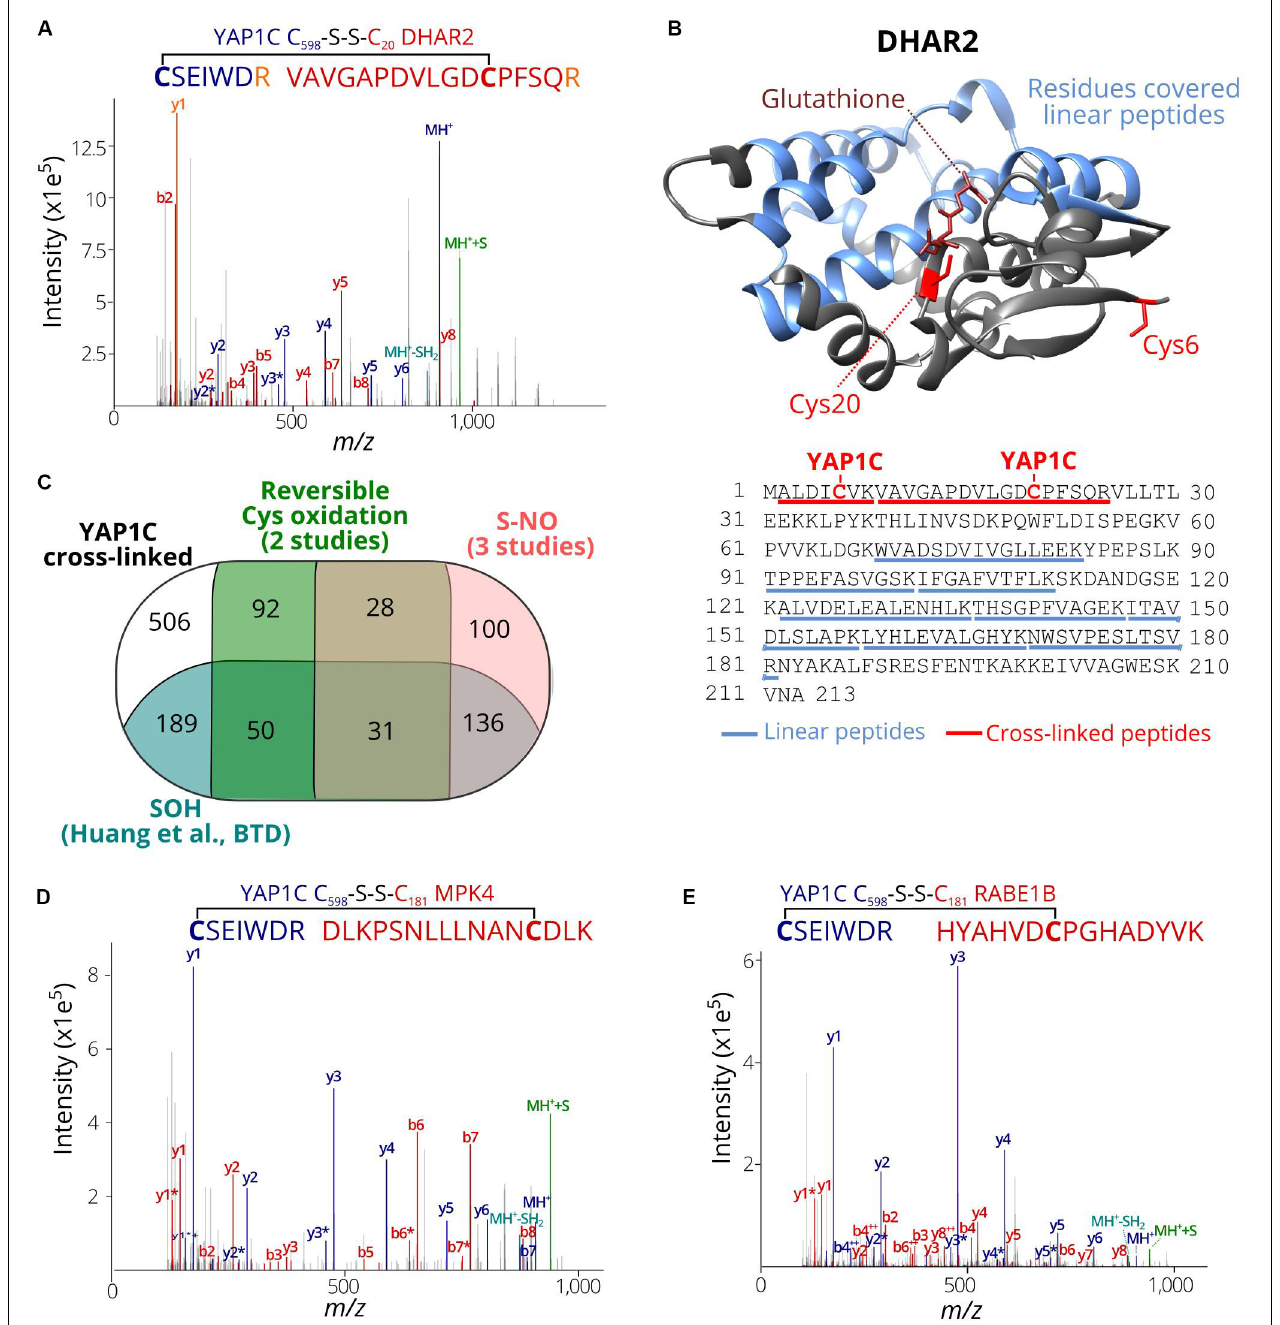
FIGURE 4 | S -sulfenylated sites identified by C 598 SEIWDR CL peptides corresponding to previously identified redox-sensitive cysteines. (A) Annotated MS/MS spectrum of C#SEIWDR (blue) linked to VAVGAPDVLGDC#PFSQR (red, Cys20 of DHAR2). The y1 fragment ion (corresponding to the C-terminal Arg) (orange) is shared by both peptides. (B) DHAR2 structure (PDB ID: 5LOL) (Bodra et al., 2017) is shown. YAP1C disulfide CL Cys6 and Cys20 are highlighted in red sticks, glutathione in the active site in brown, and the 96 residues covered by linear peptides in blue. The structure was generated using Chimera version 1.12 (Pettersen et al., 2004). (C) Venn diagram displaying the overlap of 1,132 S -sulfenylated sites ( ≥ 2PSMs) identified in this study (black) with previously reported Arabidopsis S -sulfenylated sites (blue) (Huang et al., 2019), S -nitrosylated sites (pink) (Fares et al., 2011; Puyaubert et al., 2014; Hu et al., 2015) and reversibly oxidized cysteine sites (green) (Liu et al., 2014, 2015). (D) Annotated MS/MS spectrum of C#SEIWDR (blue) linked to DLKPSNLLLNANC#DLK (red; Cys181 of MPK 4). (E) Annotated MS/MS spectrum of C#SEIWDR (blue) linked to VAVGAPDVLGDCPFSQR (red). For all annotated MS/MS spectra, the C 598 SEIWDR fragment ions are colored in dark blue. Persulfide and cysteine-to-dehydroalanine fragment ions are in green and light blue, respectively. Fragment ions of Arabidopsis peptides linked with sulfenylated cysteines are in red.